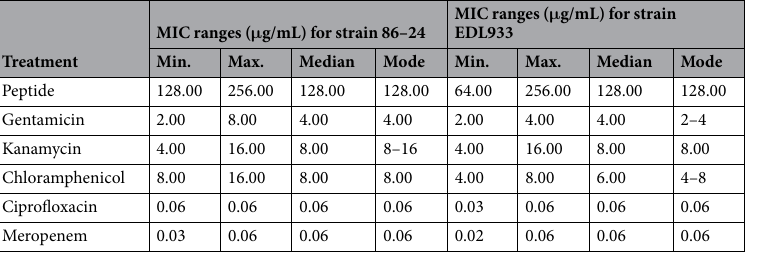
Table 1. MIC values for the peptide and selected antibiotics, as determined by a standard MIC assay. All assays were carried out in triplicate and on at least two different